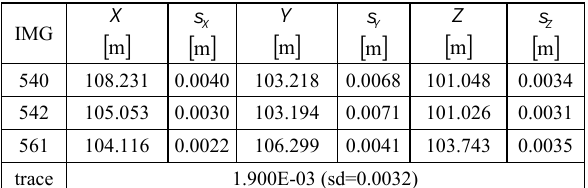
Table 4. Coordinates of image projection centers and